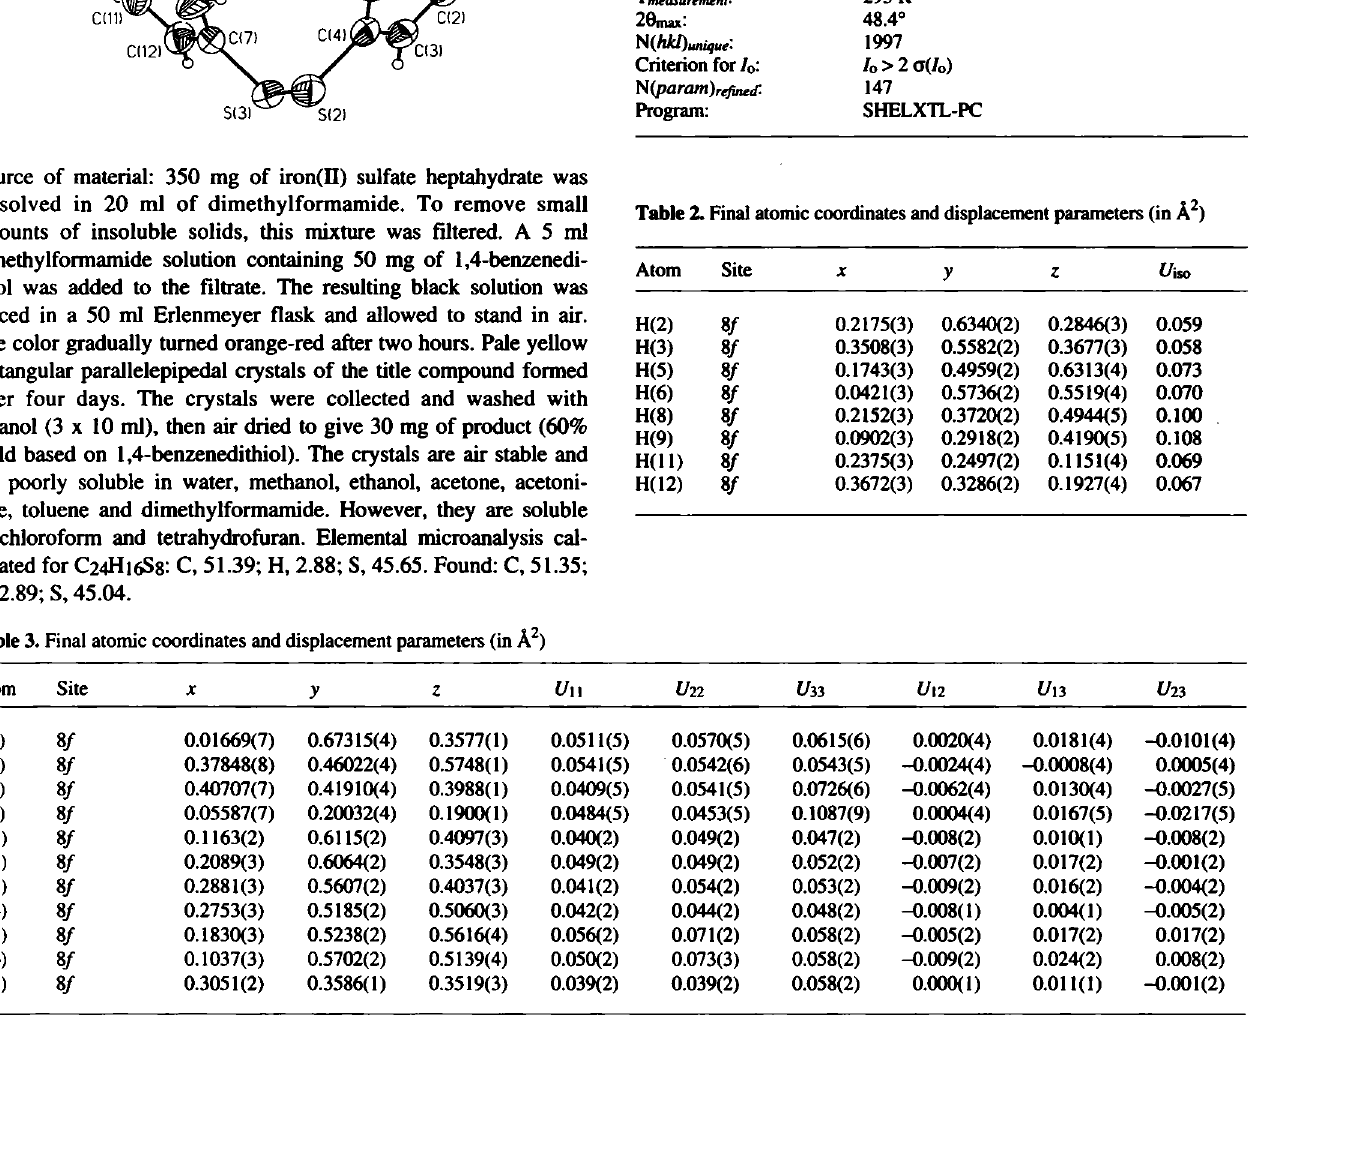
Table 1. Parameters used for the X-ray data collection Crystal: